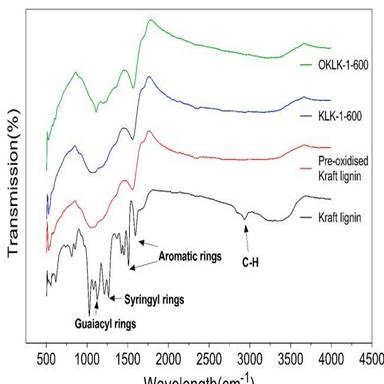
FT-IR spectra of KL, OKL, KLK-1–600 and OKLK-1–600.